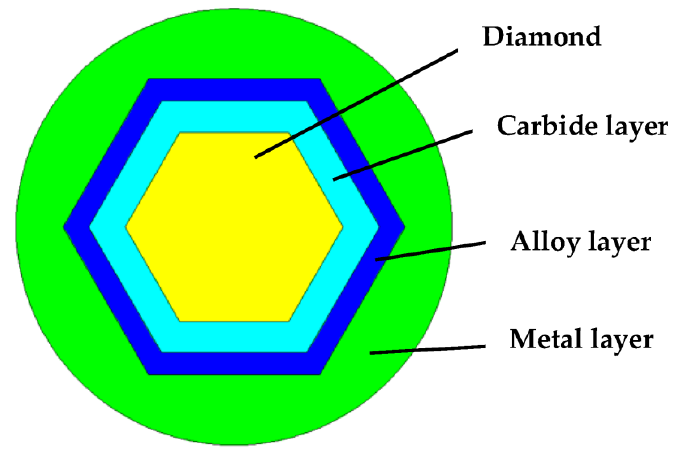
Figure 2. Model diagram of diamond surface metallization.